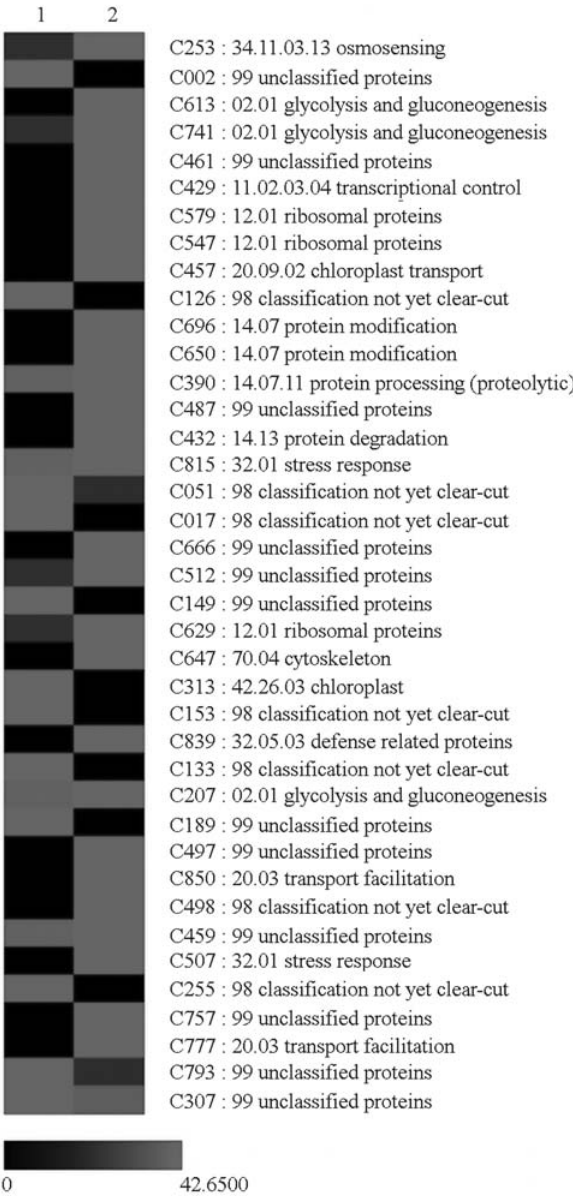
Figure 2 - Expression profiles of putative Rangpur lime water stress- related EST contigs. Scale represents relative abundance of reads in: 1-non-stressed root library and 2- roots under osmotic stress. Each profile is followed by the contig ID, the number of the MIPS functional category and the description of the functional